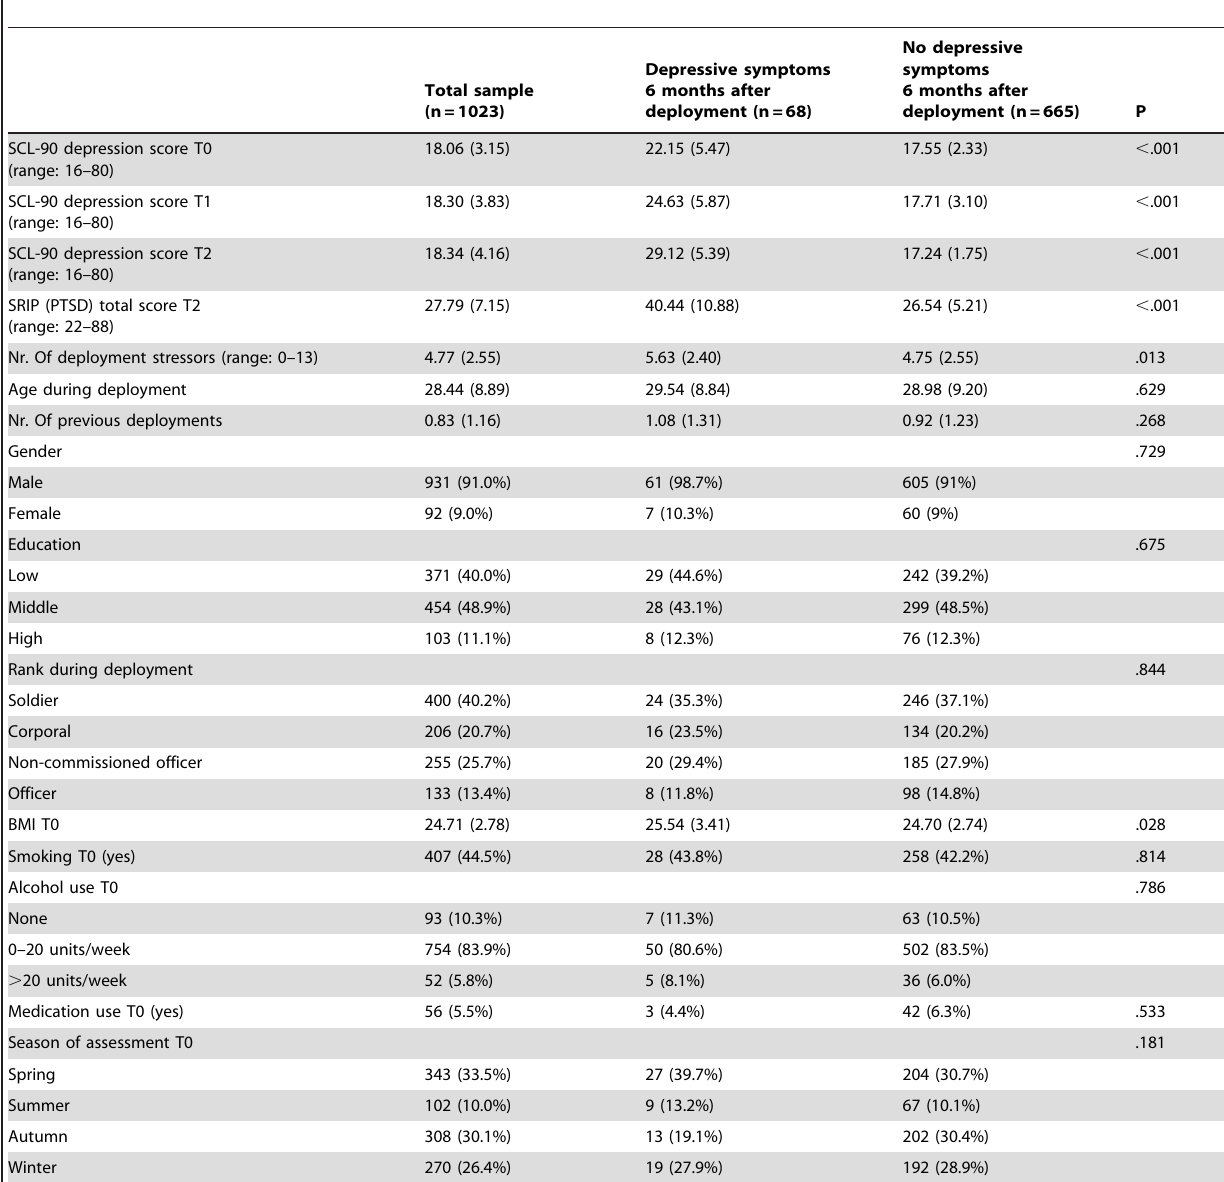
Table 2. Questionnaire scores and deployment, demographic and pre-deployment characteristics of the total sample, and the sample divided based on depressive symptoms 6 months after return from